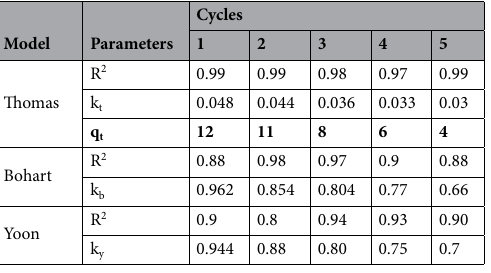
Table 7. Summary of the experiments obtained with material ECx in process of desorption’s. Significance values are in bold.